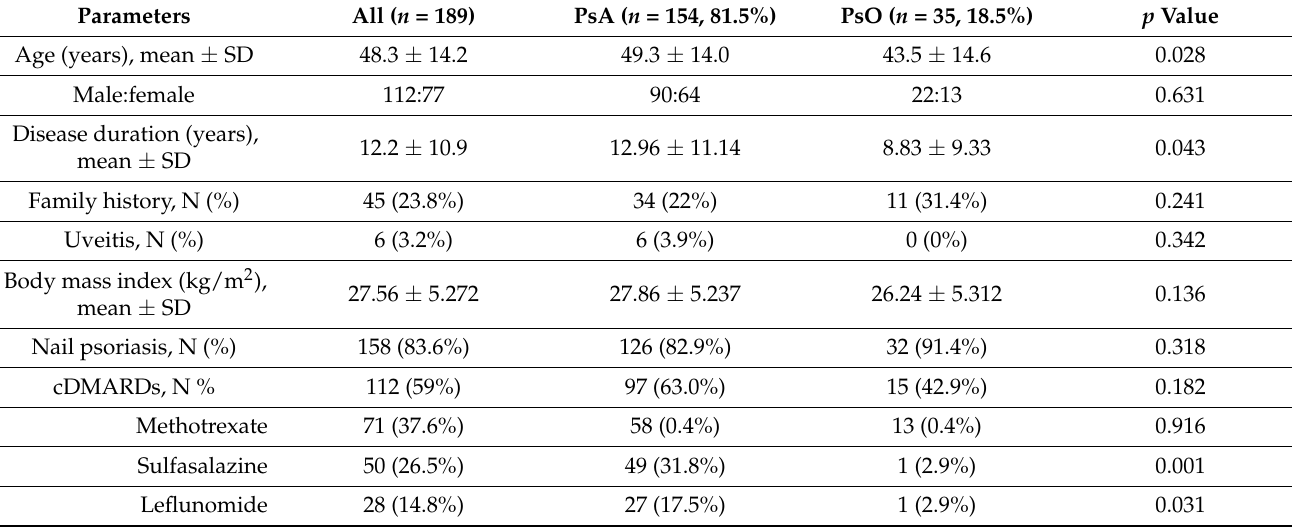
Table 1. Demographic profile of study population and disease-related data for PsO and PsA